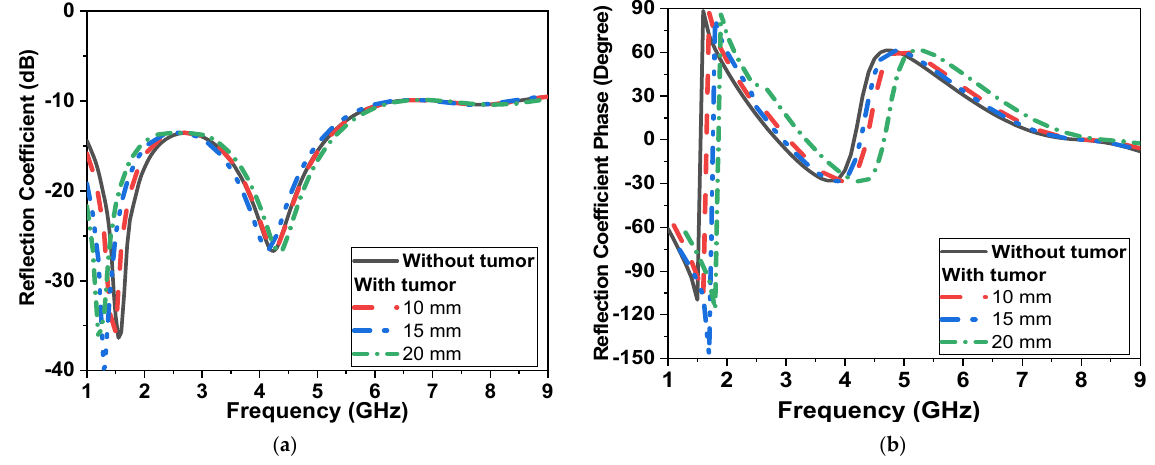
Figure 11, Simulation |S 11 | of the proposed CPMS sensor with tumor model (first scenario shown in Figure 10a) ( a ) magnitude in dB, ( b ) phase in degrees. In the second scenario, shown in Figure 10b (transmission measurement using two sensors placed on the breast sides), results are recorded in Figure 12. By increasing the diameter of the tumor model from 0 to 20 mm, changes in magnitude and phase of reflec ‐ tion and transmission coefficient are recorded in Figures 12 and 13. The tumor induced a down ‐ shift in resonant frequency by 200 MHz and 500 MHz and a change in|S 11 | magni ‐ tude by 5 dB and 15 dB, respectively, as shown in Figure 12a. The phase of reflection |S 11 | is changed from − 150° at 1.7 GHz to 180°, as shown in Figure 12b. The magnitude and phase of the transmission coefficient are shown in Figure 13. The magnitude of |S 21 |is changed by 10 dB over the operating band due to an increase in tumor size, as shown in Figure 13a. In order to monitor circularly polarized operations, the axial ratio is recorded, as shown in Figure 14, in both scenarios. The axial ratio is shifted down by 500 MHz due to the varying size of the tumor, as presented in Figure 14a. In the second scenario, with two sensors placed on the breast phantom, the operating band with an axial ratio of less than 3 dB is changed from 2.5 GHz to 3 GHz and from 5 to 8 GHz. With the presence of the tumor, the lower band of the CP band is shifted by 1 GHz and changed from 3.5 GHz to 4 GHz, as shown in Figure 14b. Figure 12. Simulated |S 11 | of the proposed CPMS sensor with tumor model (second scenario shown in Figure 10b) ( a ) Magnitude in dB, ( b ) Phase in